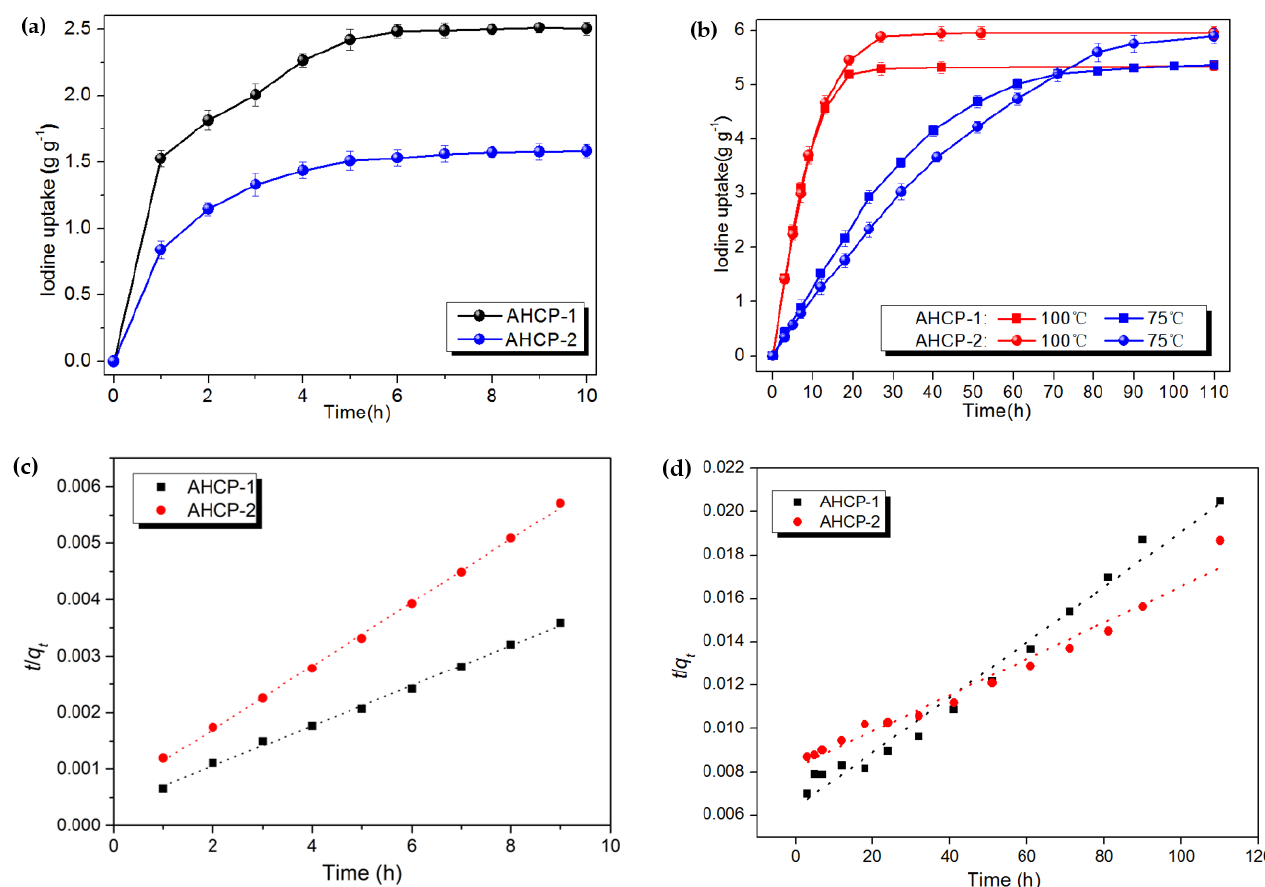
Figure 3. Gravimetric iodine uptake of AHCP-1 and AHCP-2 in ( a ) iodine aqueous solution at room temperature and ( b ) iodine vapor at 75 °C and 100 °C as a function of time. Plots of pseudo-second- order kinetics for the adsorption of ( c ) I 2 aqueous solution and ( d ) I 2 vapor at 75 °C on AHCP-1 and AHCP-2.